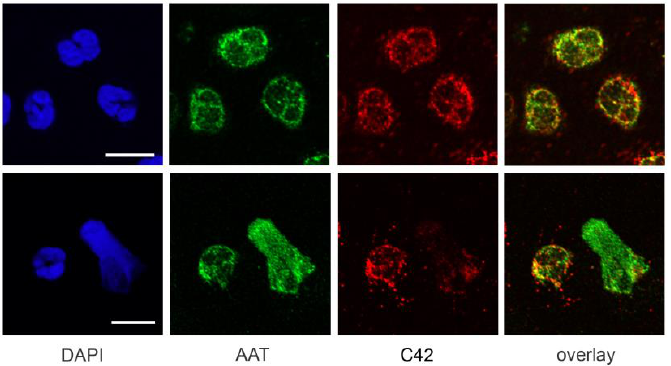
Figure 5. Distribution of the C36 peptide and full-length AAT in human neutrophils. Double labeling experiment showed very limited co-localization between C-36 ( red , stained with C42 mAb) and full-length AAT ( green , stained with polyclonal anti-AAT) patterns in untreated (upper raw) and LPS-stimulated (lower raw) neutrophils. Nuclei and DNA fibers were stained by DAPI ( blue ). Scale bar, 10 µm.